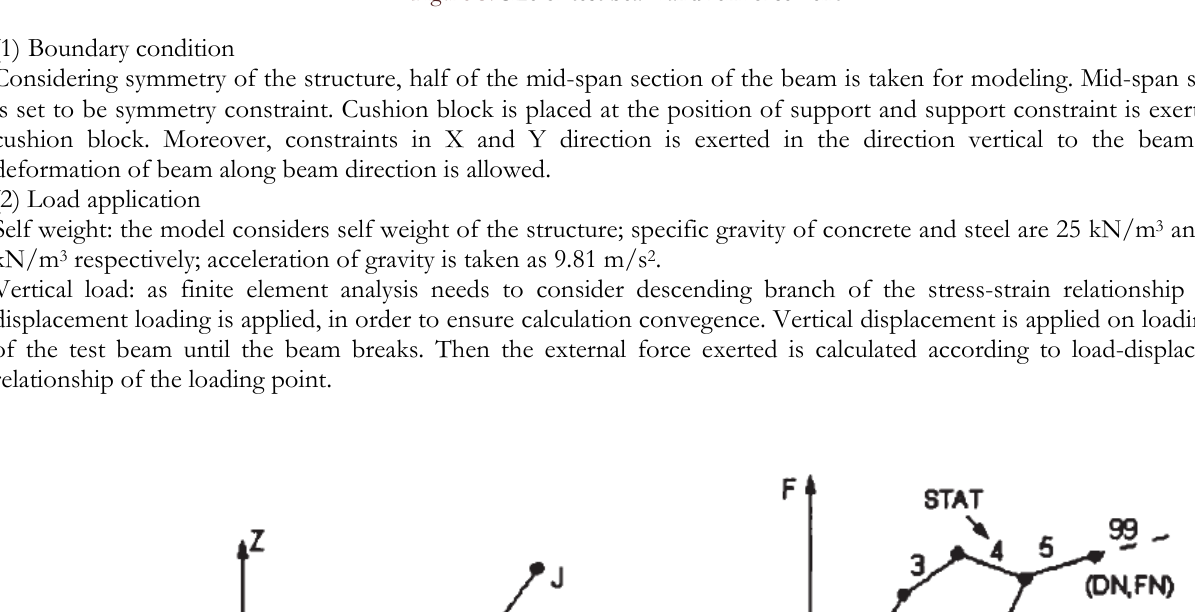
Figure 3: Size of test beam and reinforcement